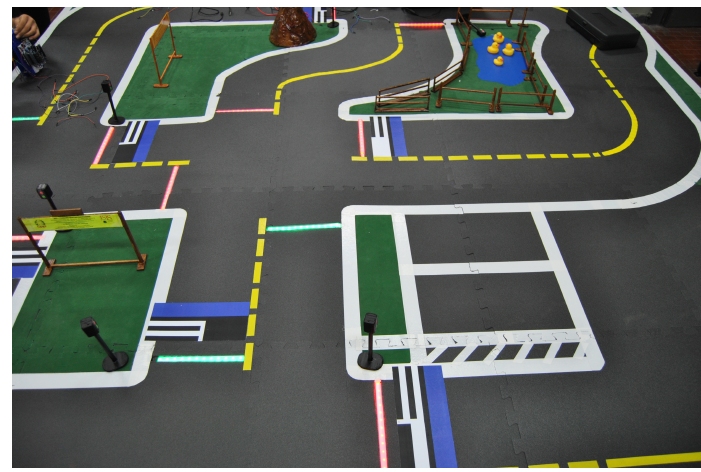
Figure 2. Roobopoli city.